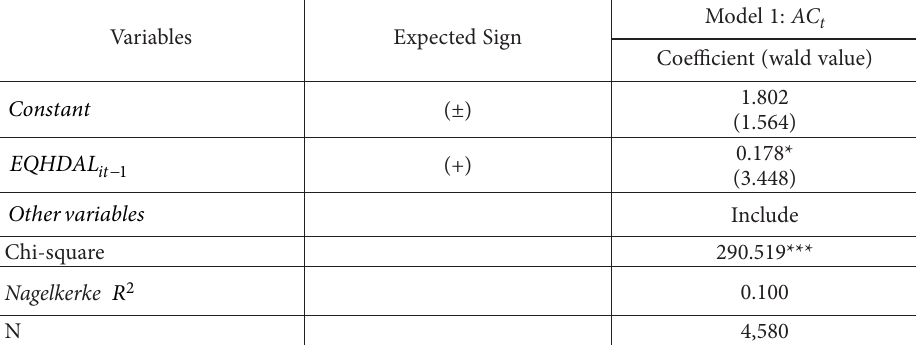
Table 5. Results for the joint effect of EQCR hours and discretionary accruals on auditor changes